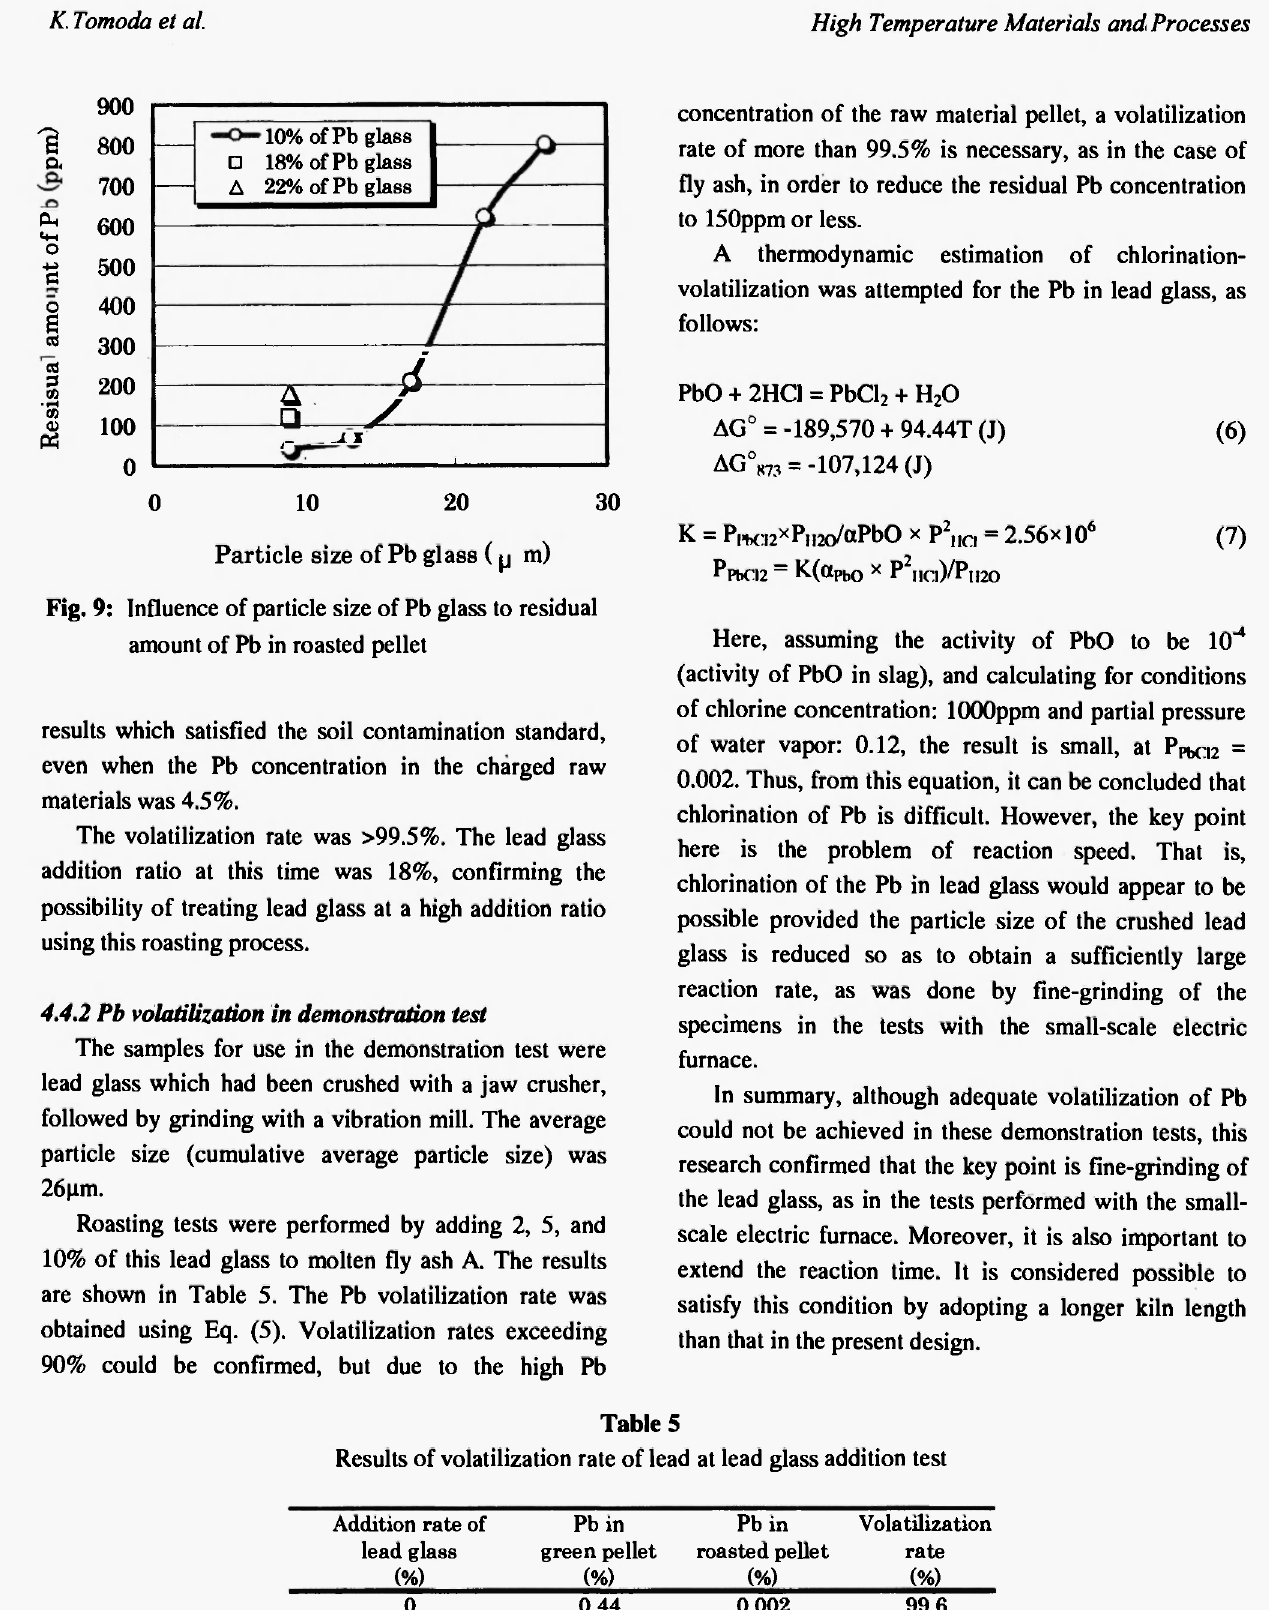
Results of volatilization rate of lead at lead glass addition test Addition rate of Pb in Pb